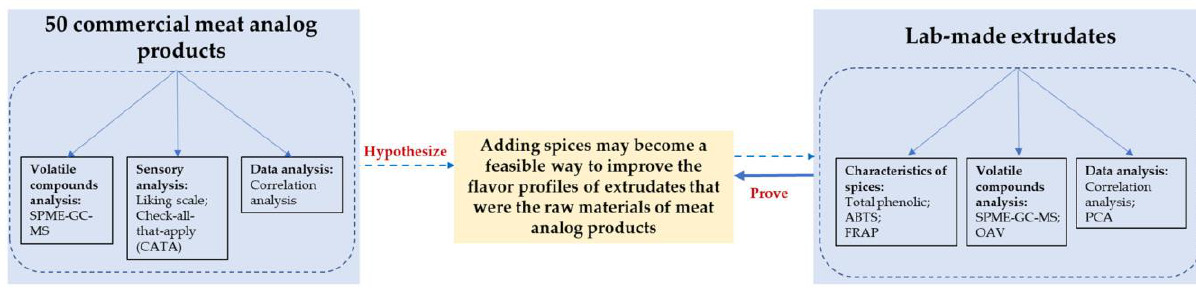
Figure 1. Technical roadmap.